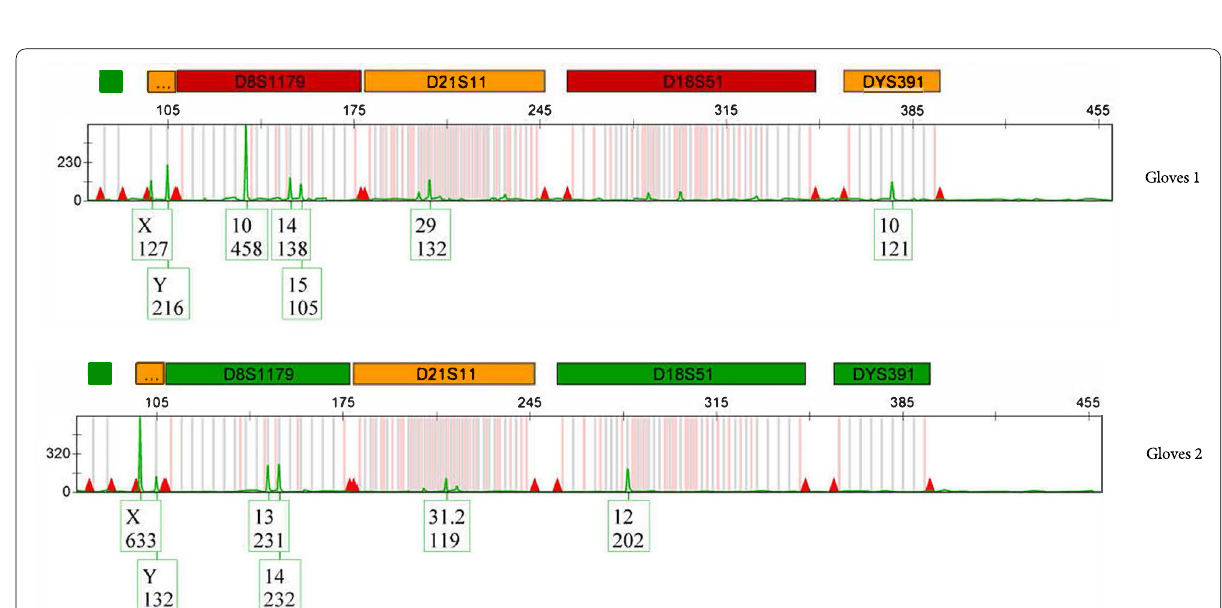
Fig. 4 Random swabbing of equipped gloves during DNA